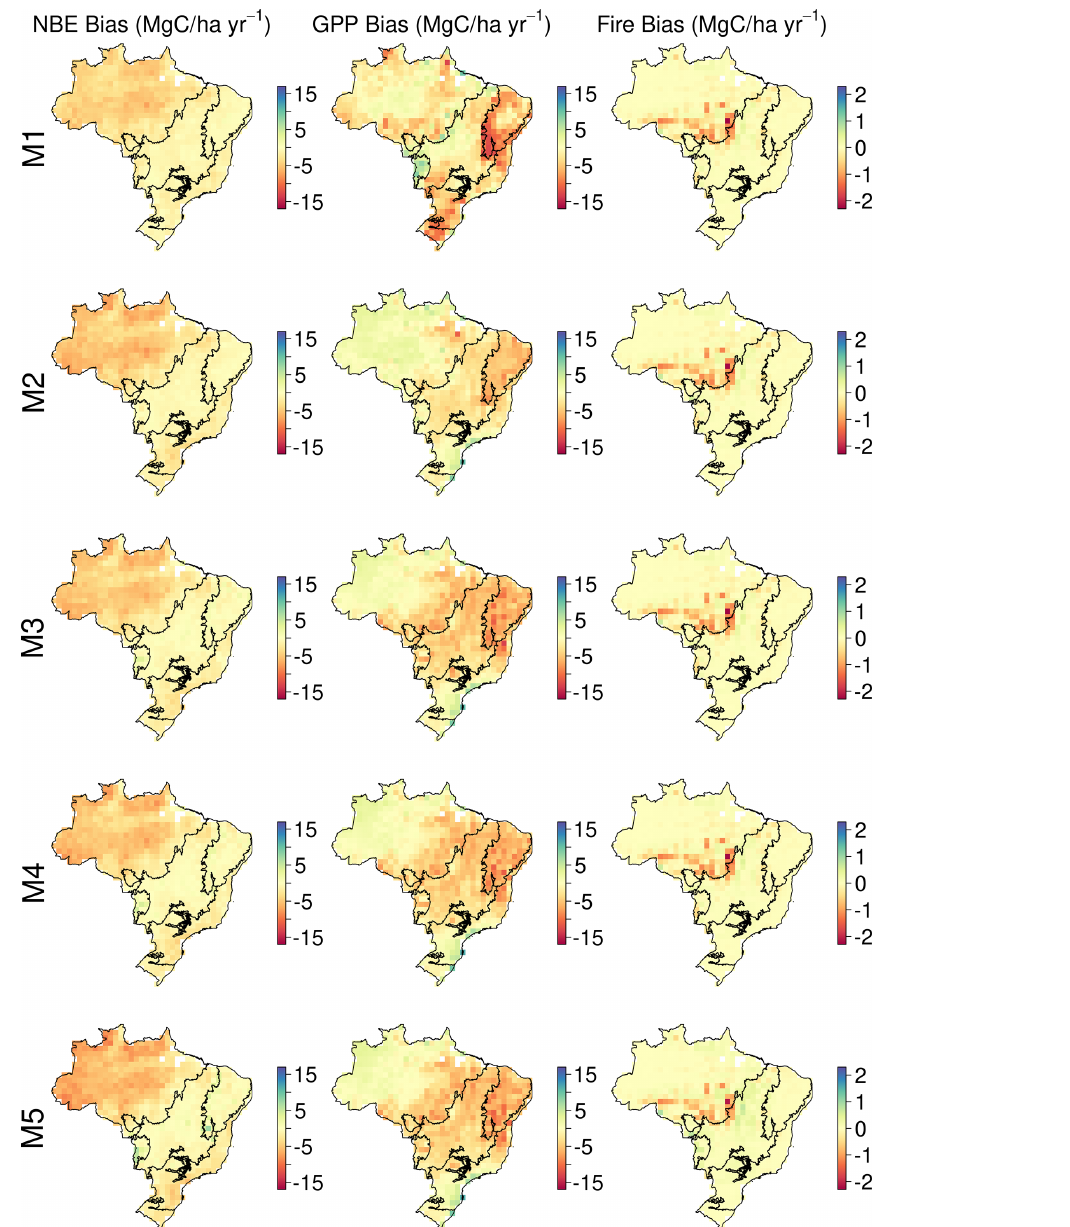
Figure A8. Maps showing the mean bias between each DALEC model and independent data for NBE, GPP and fire emissions. See Fig. 4 for